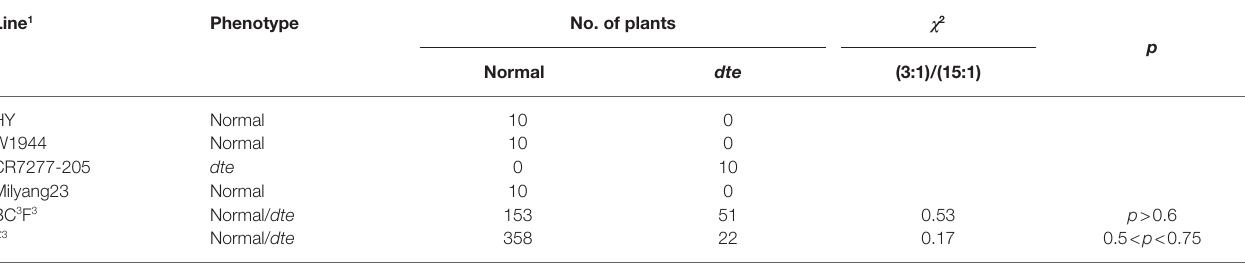
TABLE 1 | Genetic analysis of dark tip embryo (DTE) from two